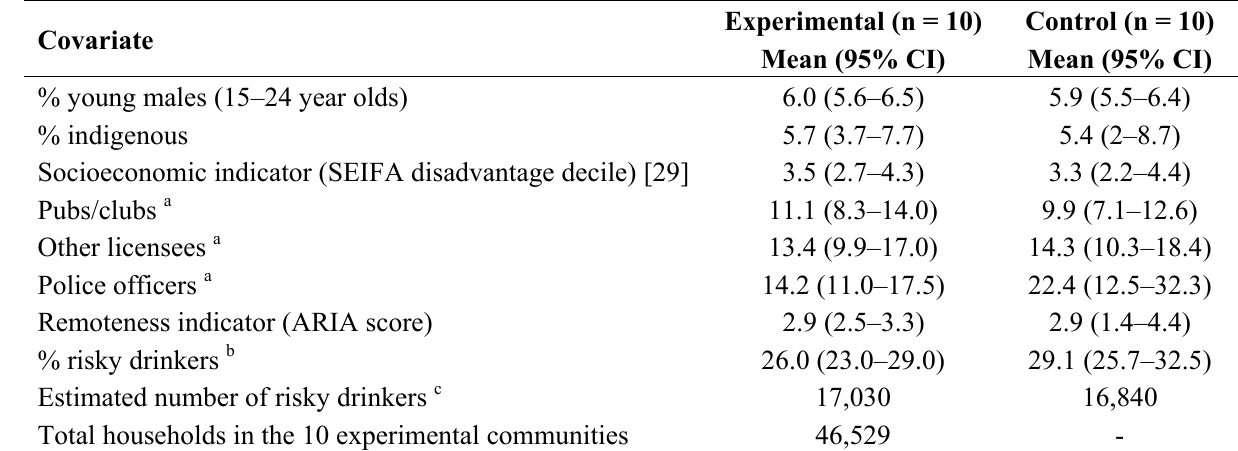
Table 1. Baseline characteristics of the experimental and control